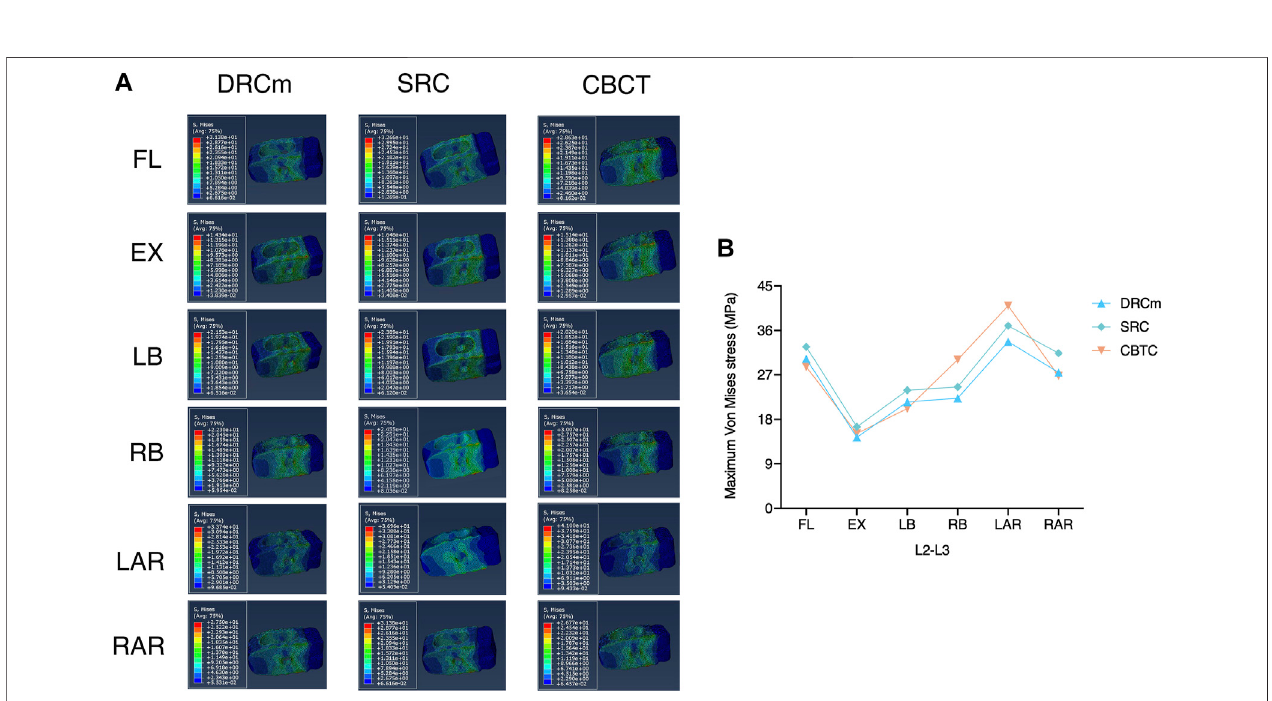
FIGURE 4 | Distribution characteristics of the maximum VMS on the cage at the revision level after RS (A) and its tendency for change among the three constructs (B) .